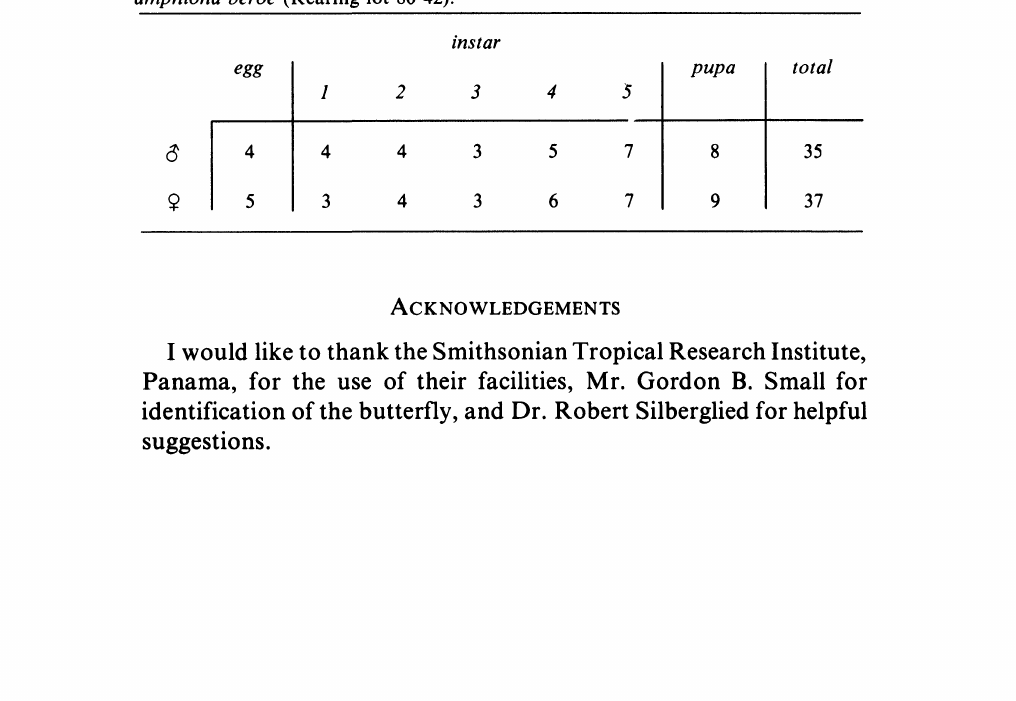
Figure 5. Larval head capsules: first instar (I-1), third instar (I-3), and fifth (final) instar (I-5). Scales Table 2. Number of days spent in each stage by the two individuals of Dismorphia amphiona beroe (Rearing lot